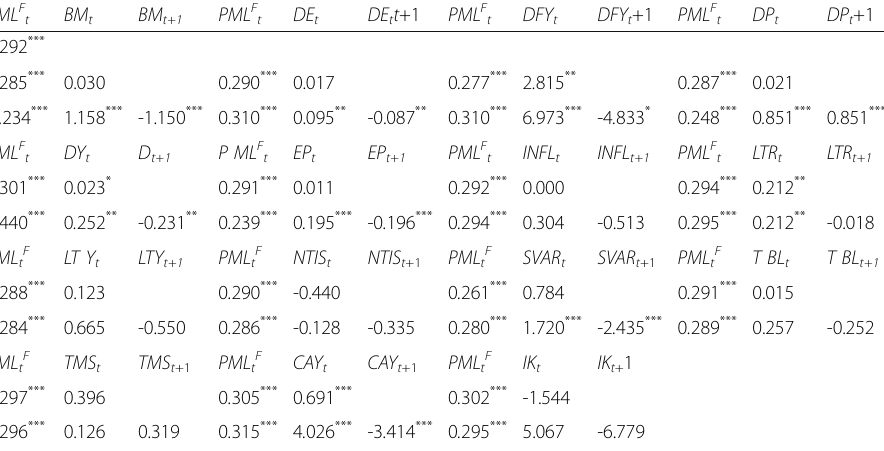
Table 13 Quarterly Regression with Business-cycle Related Variables Controlled